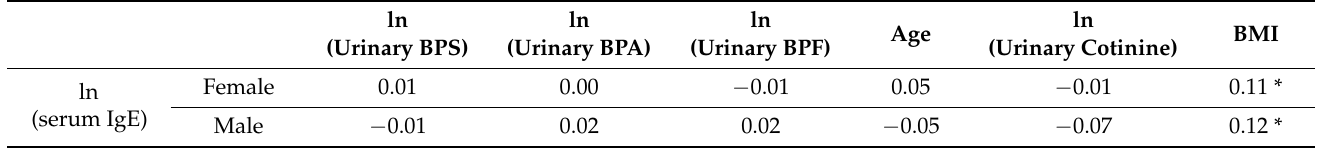
* p < 0.05. Correlation coefficient was calculated by Pearson’s correlation method. Variables with right-skewed distribution were log-transformed. p -values were calculated using non-parametric bootstrap method. Resampling was performed 2000